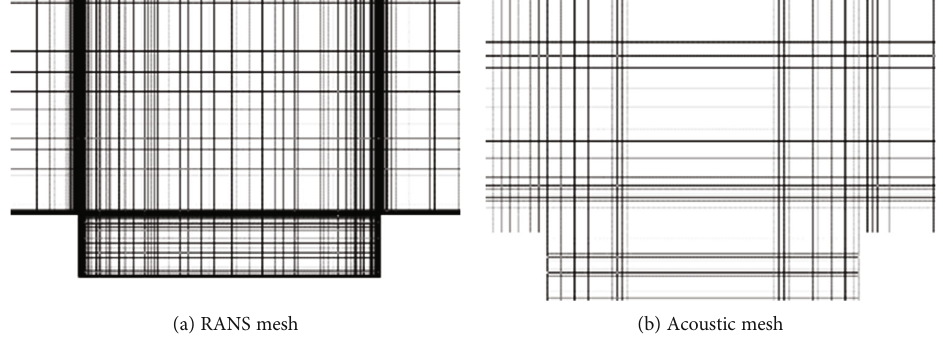
Figure 4: Comparison of RANS and acoustic meshes.